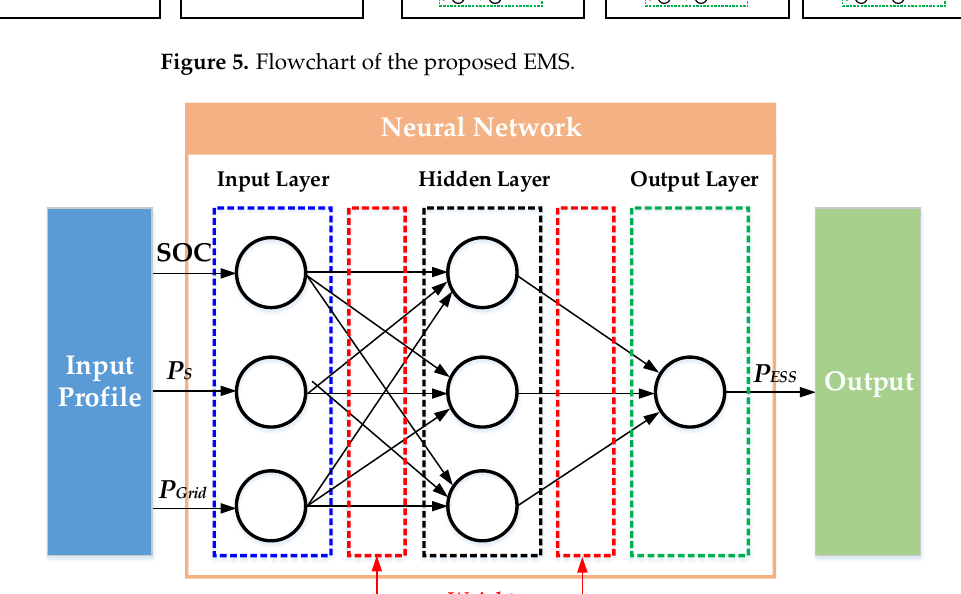
Figure 6. Configuration of the proposed ANN.